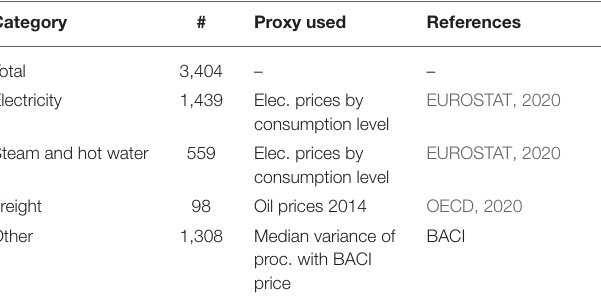
TABLE 2 | Categorisation of the processes with non-zero production in the Swiss Household consumption final demand, but without matching BACI trade flows. Category Proxy